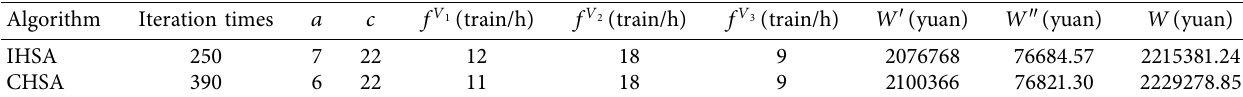
Table 8: Comparative analysis of IHSA and CHSA (the first set of parameters).